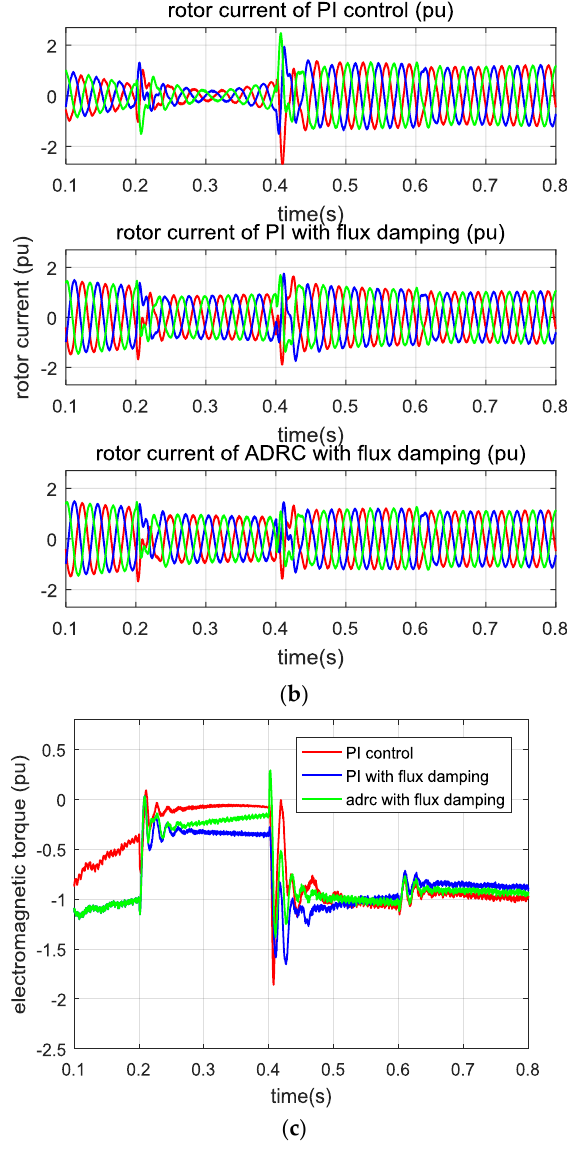
Figure 10. Symmetrical 60% voltage dip case: ( a ) DC bus voltage; ( b ) rotor current; and ( c ) electromagnetic torque. Table 2. Performance index comparison for the symmetrical 60% voltage dip case. Table 2. Performance index comparison for the symmetrical 60% voltage dip